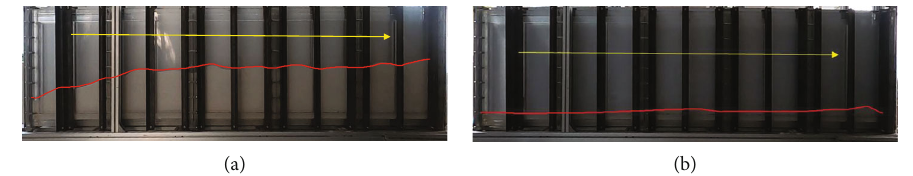
Figure 12: Con fi guration of 40/70 mesh quartz sand with di ff erent fracturing fl uid viscosities: (a) viscosity of 5 mPa s and (b) viscosity of 14mPa s.